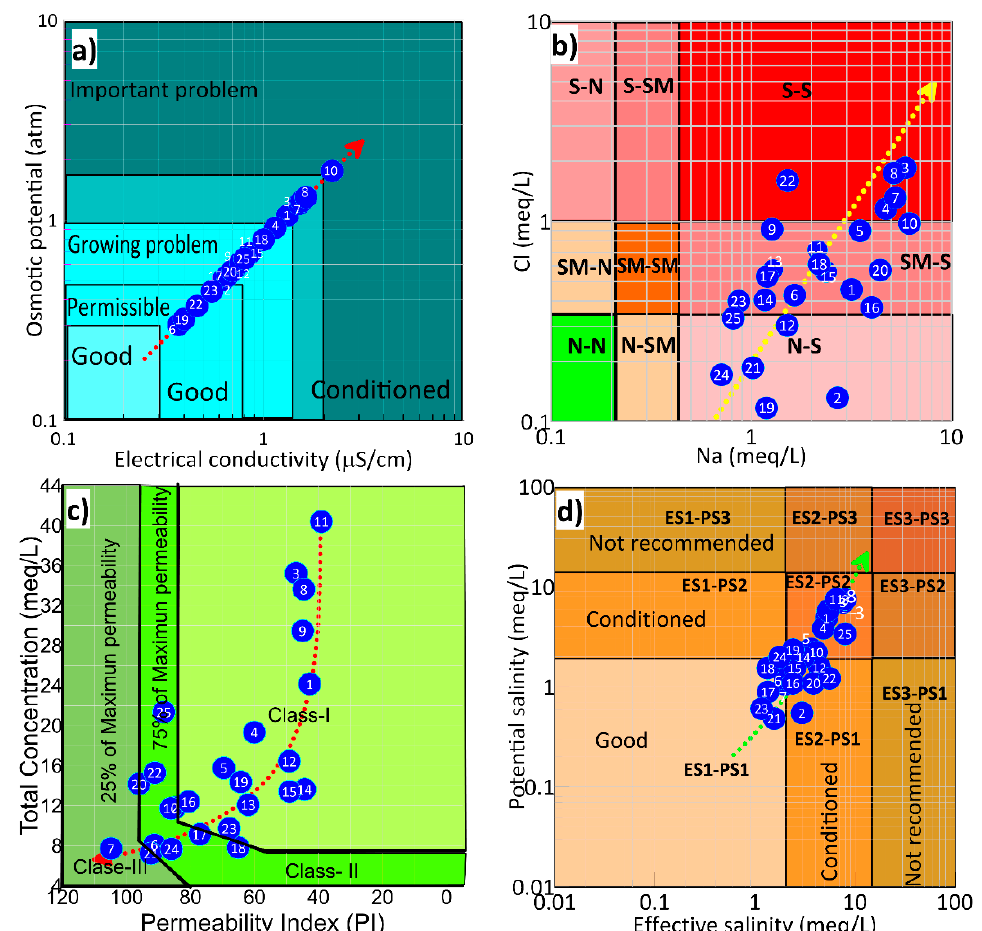
Figure 9. Spatial distribution of the indices: ( a ) EC vs. OP, ( b ) Na vs. Cl, ( c ) PI vs. TC, and ( d ) ES vs. PS.